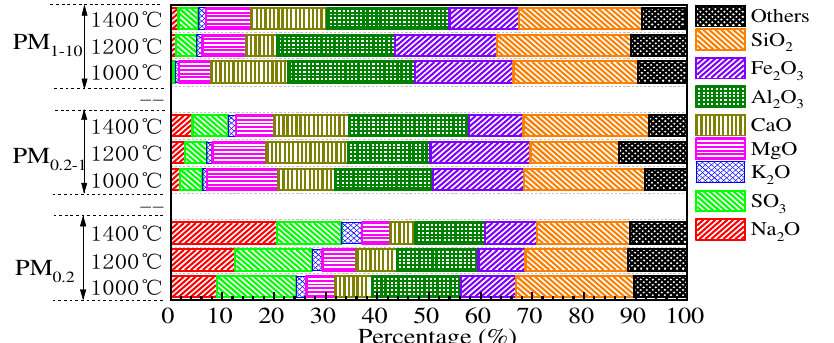
Figure 3. Composition of significant mineral components in PM10.